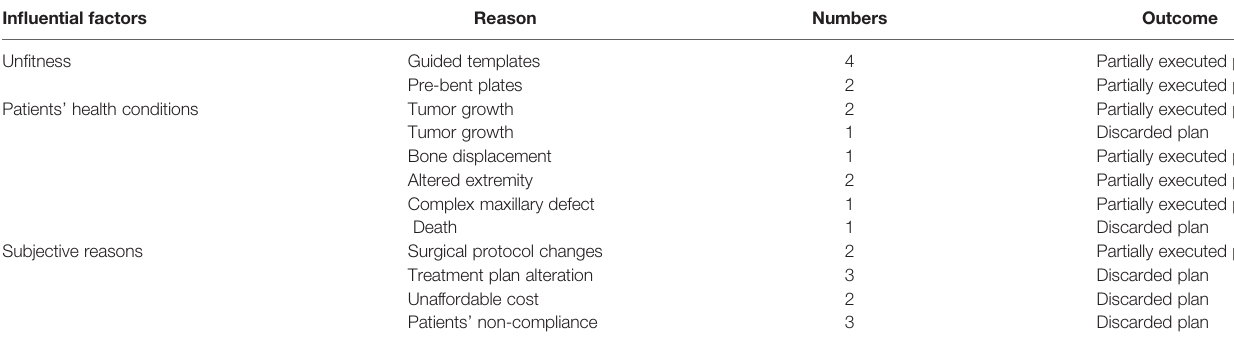
TABLE 2 | Partially executed or discarded plan with reasons.